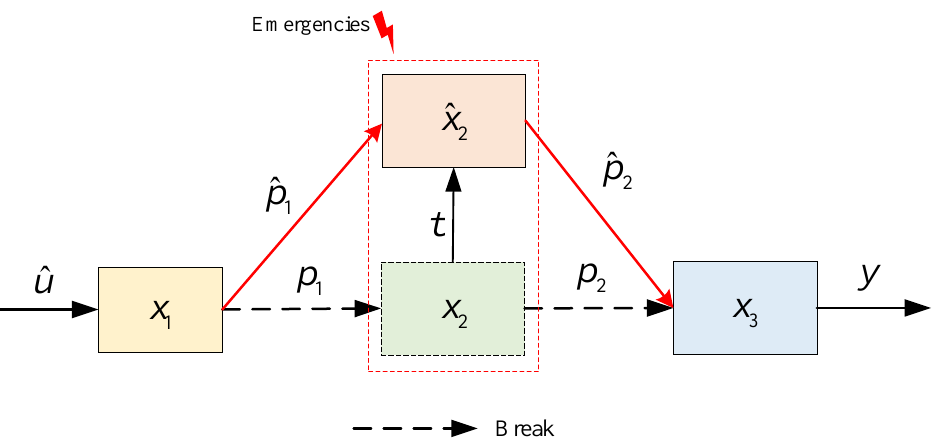
Figure 6. Diagram of the change of distributors in the three-level supply chain